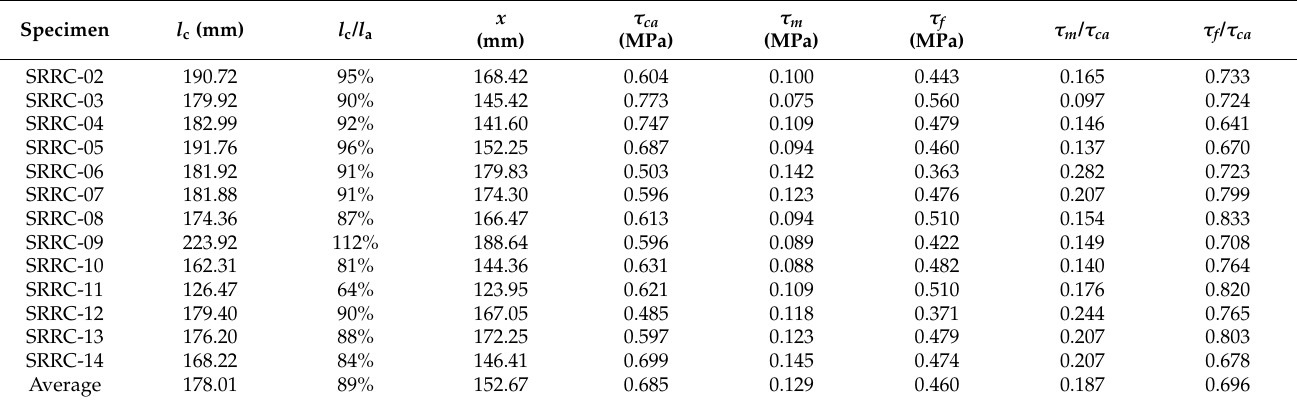
Table 4. Composition and solution of bonding stress.